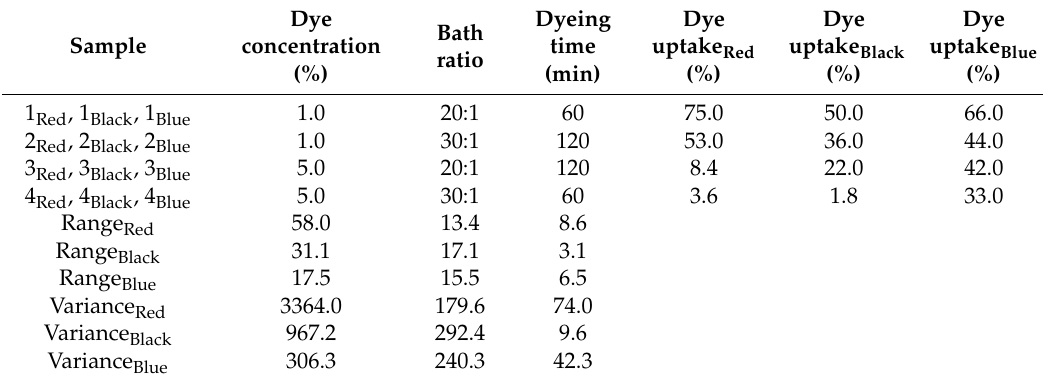
Table 1. L 4 (2 3 ) results of dye uptake by F. mandshurica